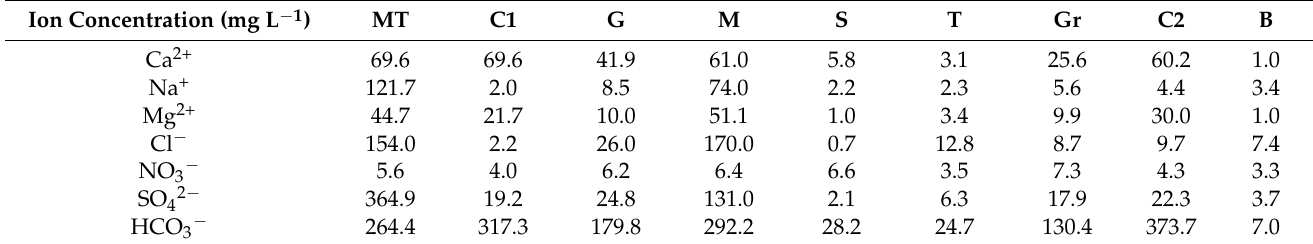
Table 3. Ion concentration obtained by IC (Cl − , SO 42 − and NO 3 − ), acid–base titration (HCO 3 − ) and ICP (Na + , Ca 2+ and Mg 2+ ) in the water samples.